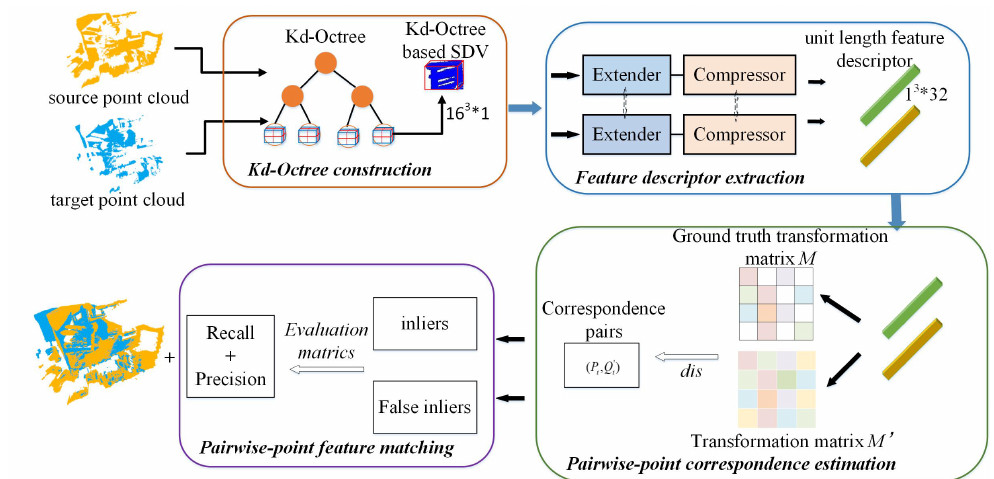
Figure 2. The processing diagram of our proposed KdO-Net method, which consists four modules: (1) Kd–Octree construction, (2) feature descriptor extraction, (3) pairwise-point correspondence estimation, and (4) pairwise-point feature